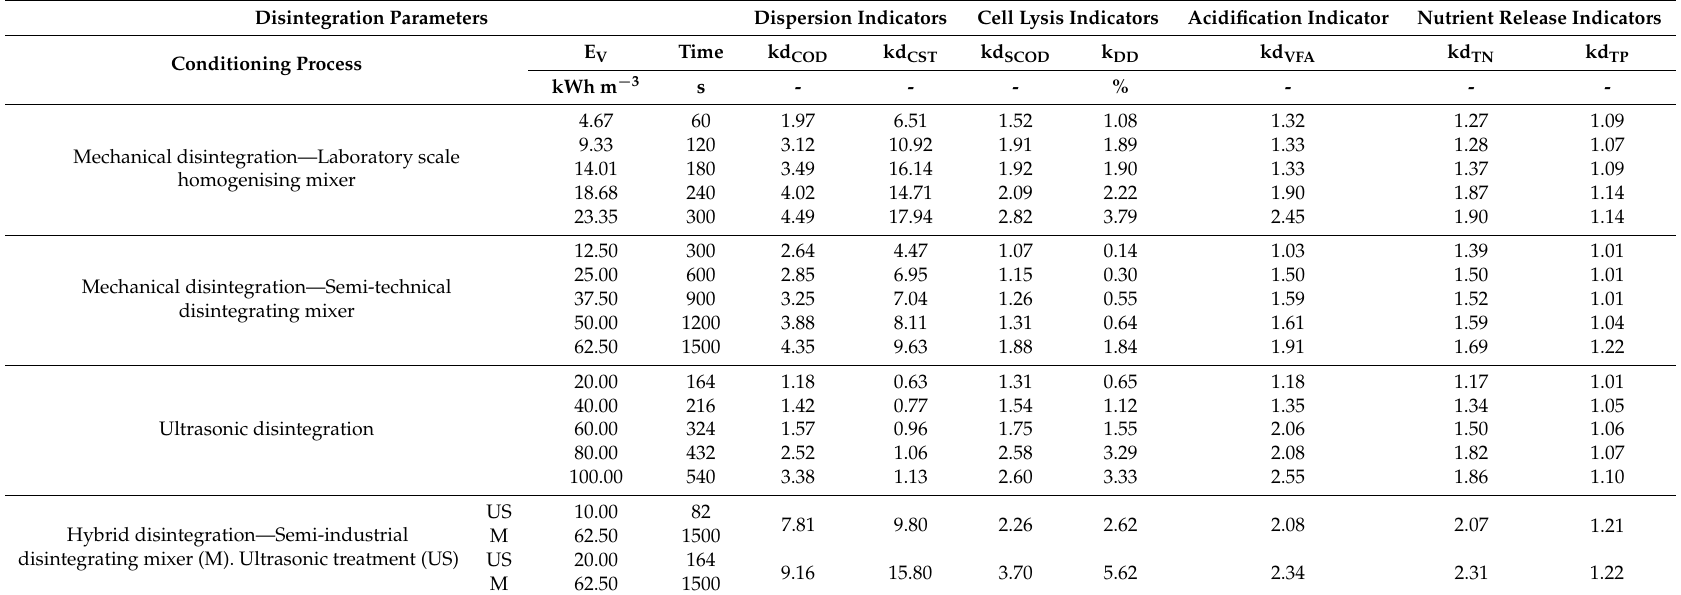
Table 5. The direct effects of mechanical disintegration of excess